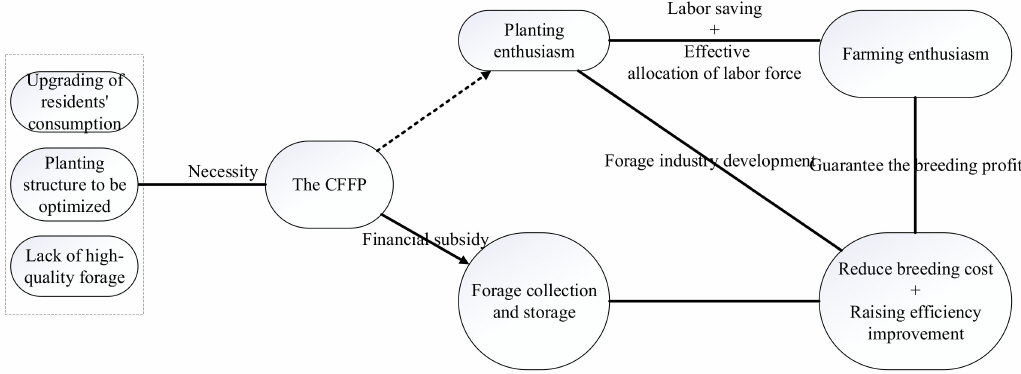
Figure 1. The implementation framework for the